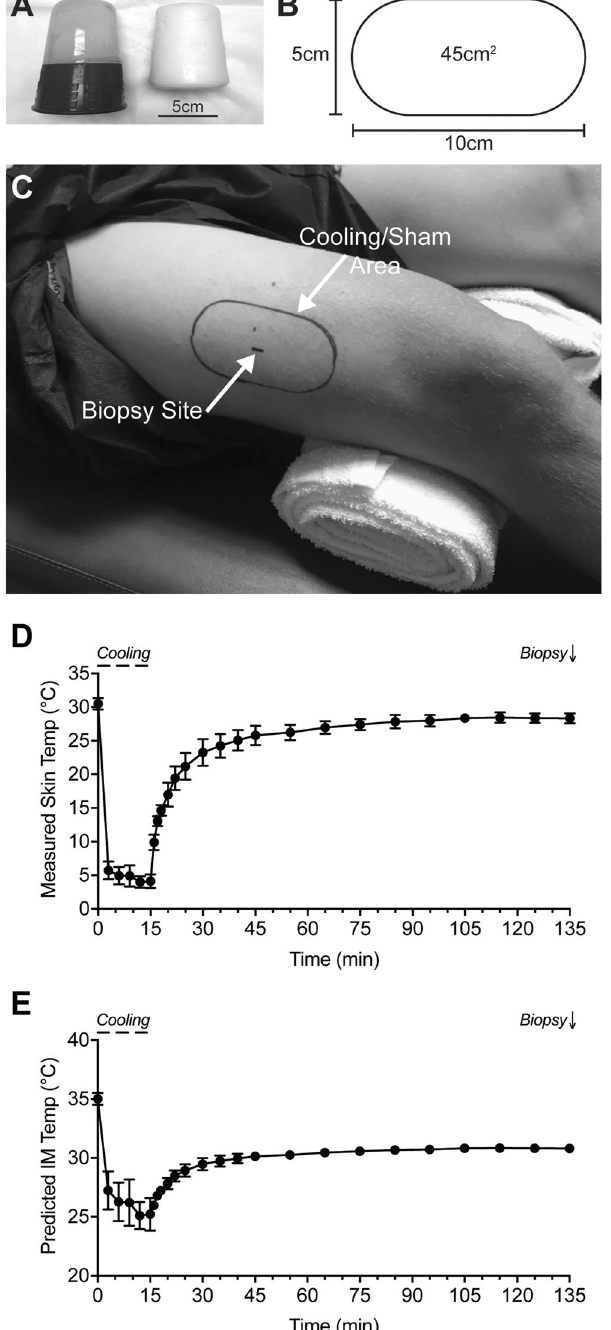
Figure 1. Overview of treatment area and temperature measurements. ( A ) Ice cup (left) and sham mold (right). ( B ) Template used to create an outline of the area to apply the cryocup or sham mold. ( C ) Demonstration of the area of the template and biopsy location on a subject. ( D ) Measured skin temperature values and ( E ) predicted intramuscular (IM) temperature measurements. Values are mean ±